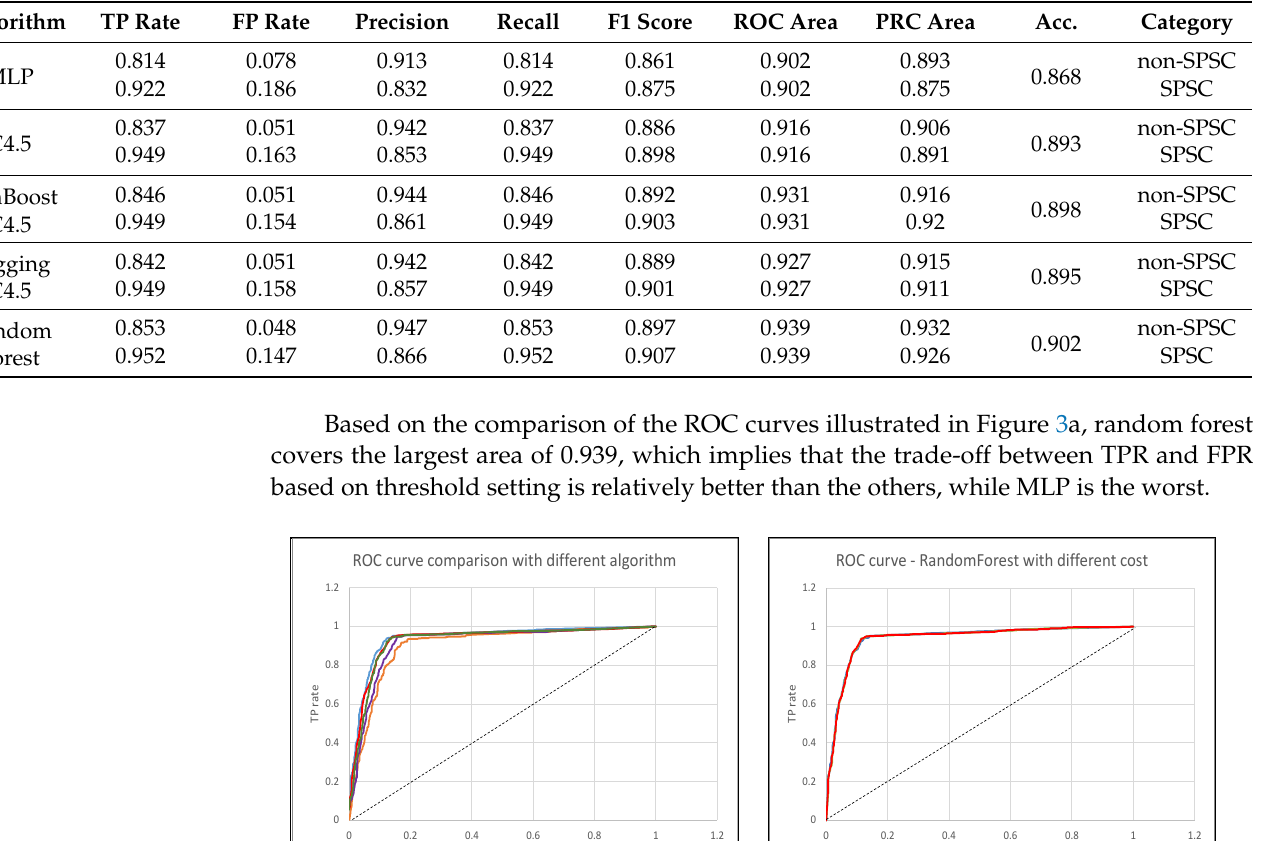
Table 3. Comparison of the random forest classification performance for different costs.